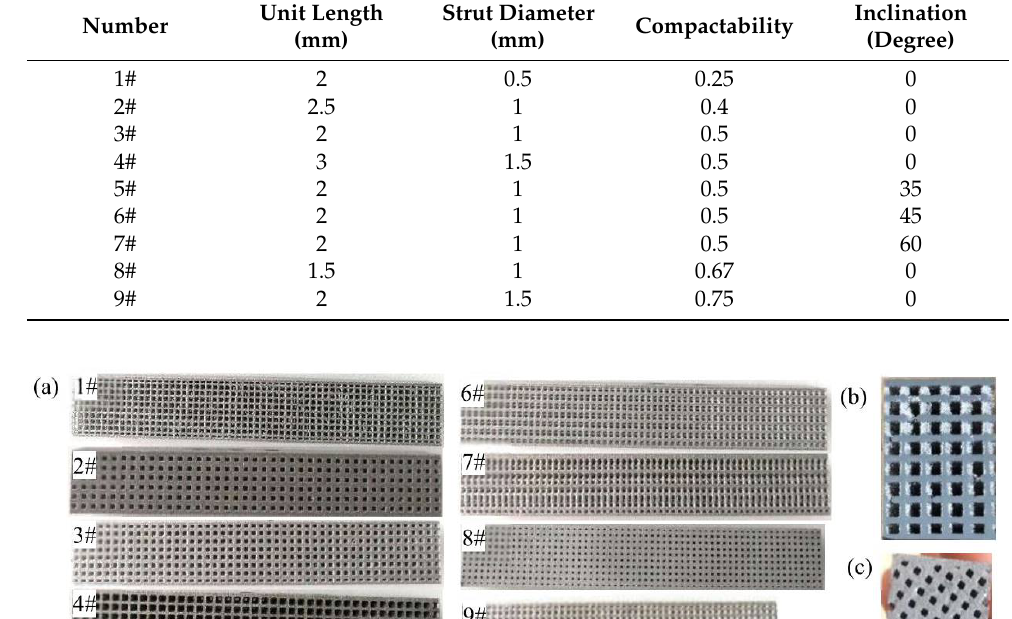
Table 1. Samples with different geometric parameters.